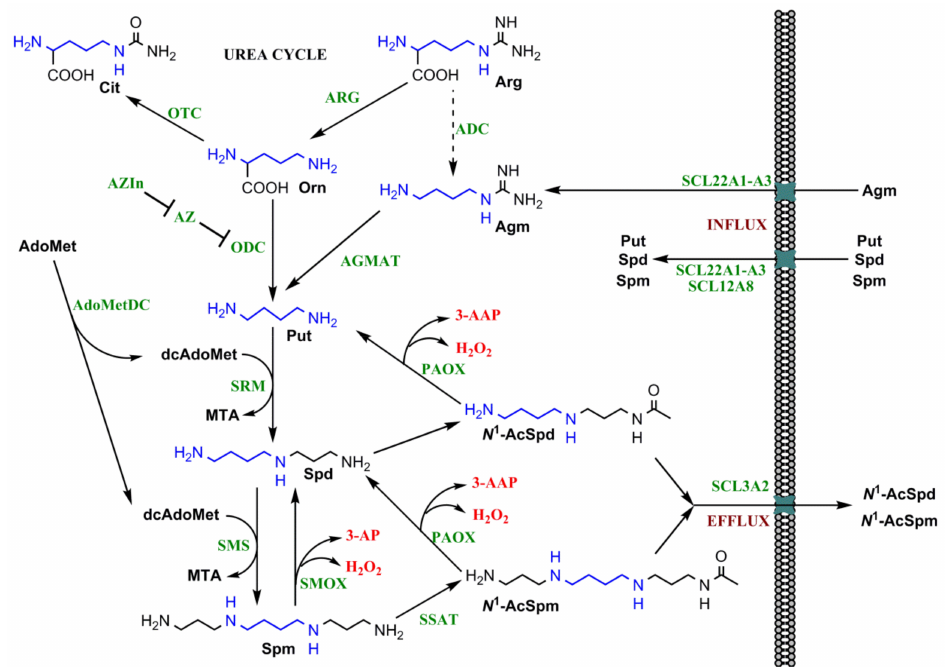
Figure 2. Scheme of metabolism of biogenic polyamines. Polyamines are synthesized from two metabolites of the urea cycle, namely arginine ( Arg ) and ornithine ( Orn ). Within this cycle, Arg is converted by arginase (ARG) into Orn , and the latter is transformed into citrulline ( Cit ) by an ornithine transcarbamylase (OTC). Polyamine precursor putrescine ( Put ) is synthesized from Orn by ornithine decarboxylase (ODC), or from Agm by agmatinase (AGMAT). The latter is a product of bacterial arginine decarboxylase (ADC) (a dashed arrow indicates absence of the enzyme in mammalian cells), whereas in mammals it is absorbed from the gut. Putrescine is converted into spermidine ( Spd ) and then to spermine ( Spm ) by spermidine and spermine synthases (SRM and SMS). The aminopropyl fragment is transferred by them from a decarboxylated S-adenosyl methionine ( dcAdoMet ) that is synthesized by S -adenosyl methionine decarboxylase (AdoMetDC). Polyamine catabolism is